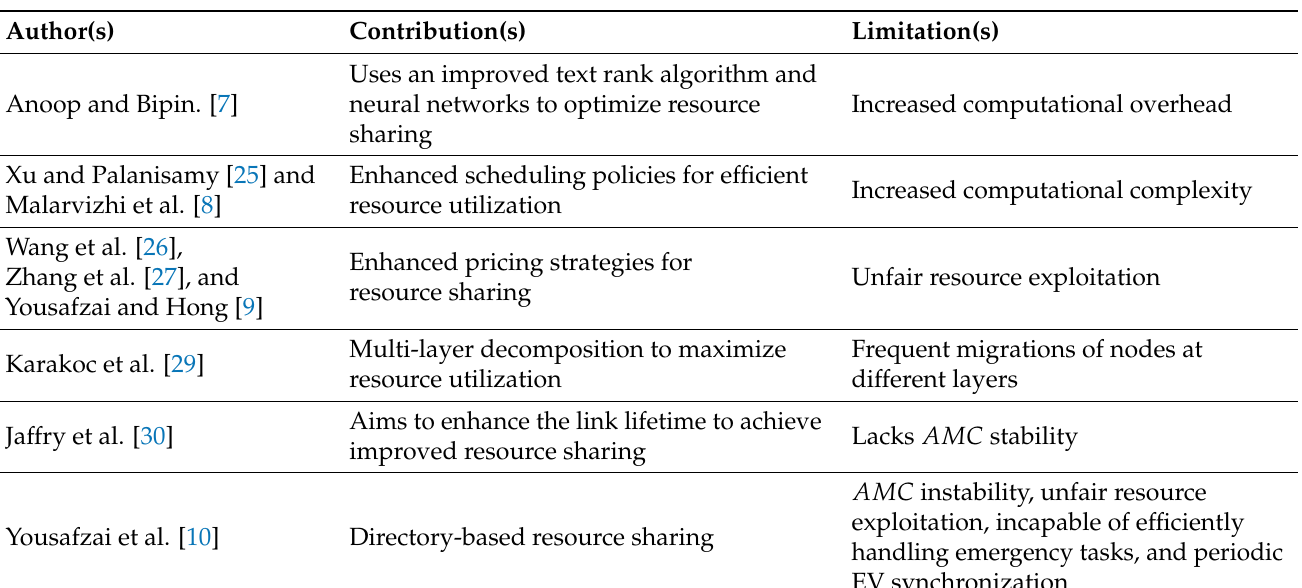
Table 2. Analysis of eminent resource sharing